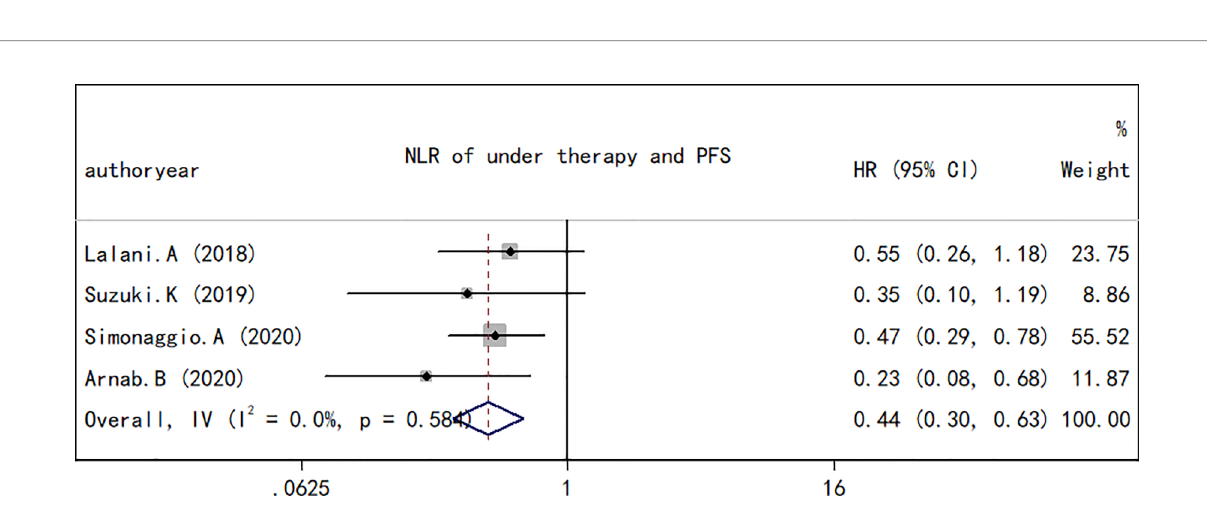
FIGURE 4 | Forest plot of hazard ratios for the association between the neutrophil-to-lymphocyte ratio under therapy and overall survival in renal cell carcinoma.